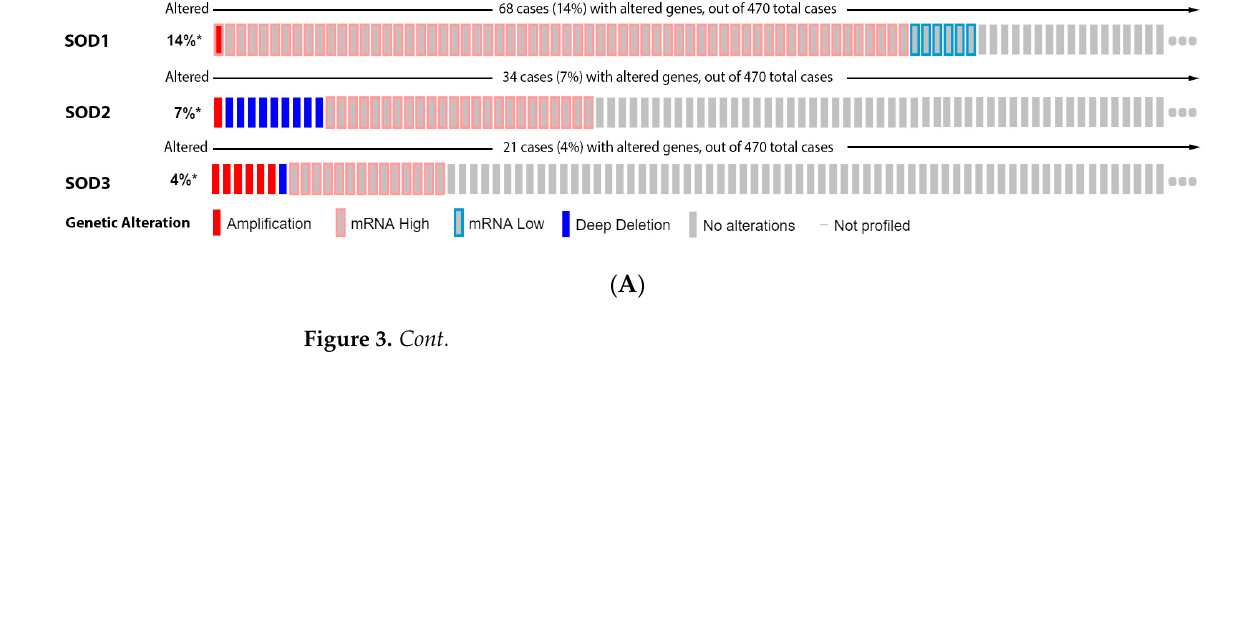
Figure 2. NADPH oxidases on melanoma. ( A ) Percentage of patients with altered genes and types of genetic alterations; ( B ) overall patient survival status, and ( C ) expression in melanoma progression. Red boxes represent the common nevus, yellow boxes the dysplastic nevus, green boxes the radial growth phase (RGP) melanoma, blue boxes the vertical growth phase (VGP) melanoma, and purple boxes the metastatic melanoma. The statistical analysis was performed by ANOVA followed by Tukey test, *** p < 0.001, ** p < 0.01, * p < 0.05 when compared to common or dysplastic nevus.